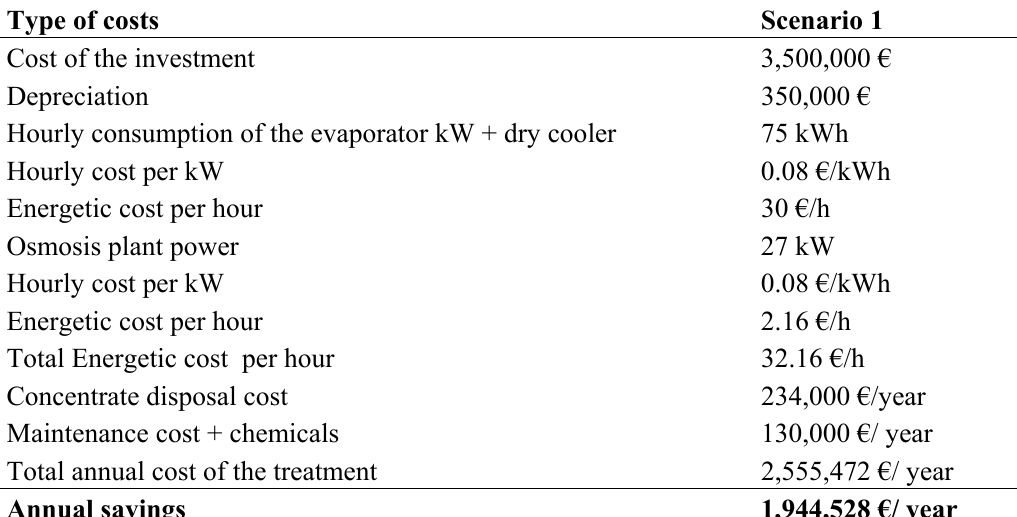
Table 2. Costs analysis Scenario